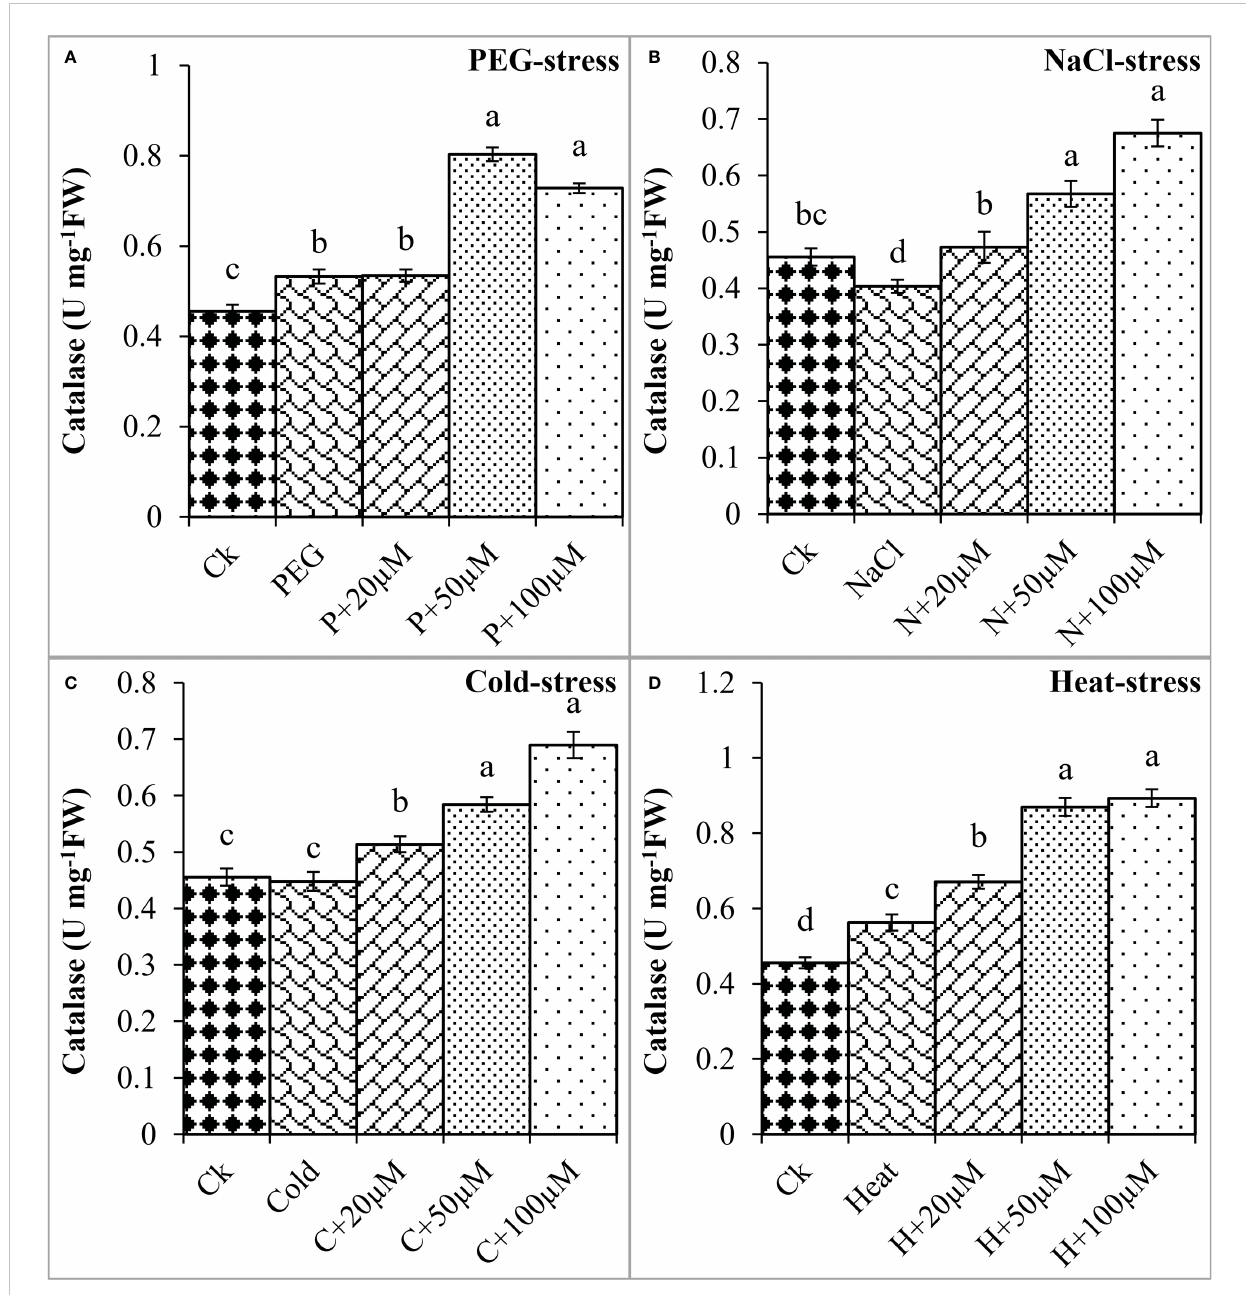
FIGURE 7 Effect of different concentrations of melatonin on the activity of Catalase (CAT) under PEG (A) , NaCl (B) , Cold (C) , and Heat (D) . Values are the means ± SD (n=3). Different letters on the bars show a statistical signi fi cance level at p<0.05 . Here, µM is indicating (µmole L -1